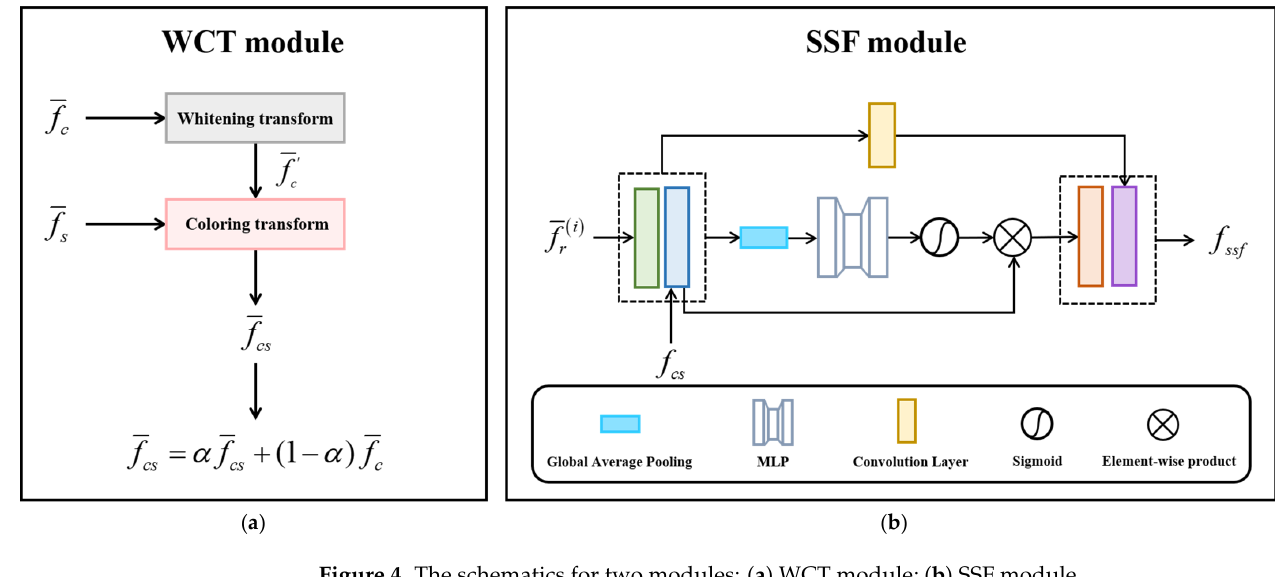
Figure 4. The schematics for two modules: ( a ) WCT module; ( b ) SSF module.